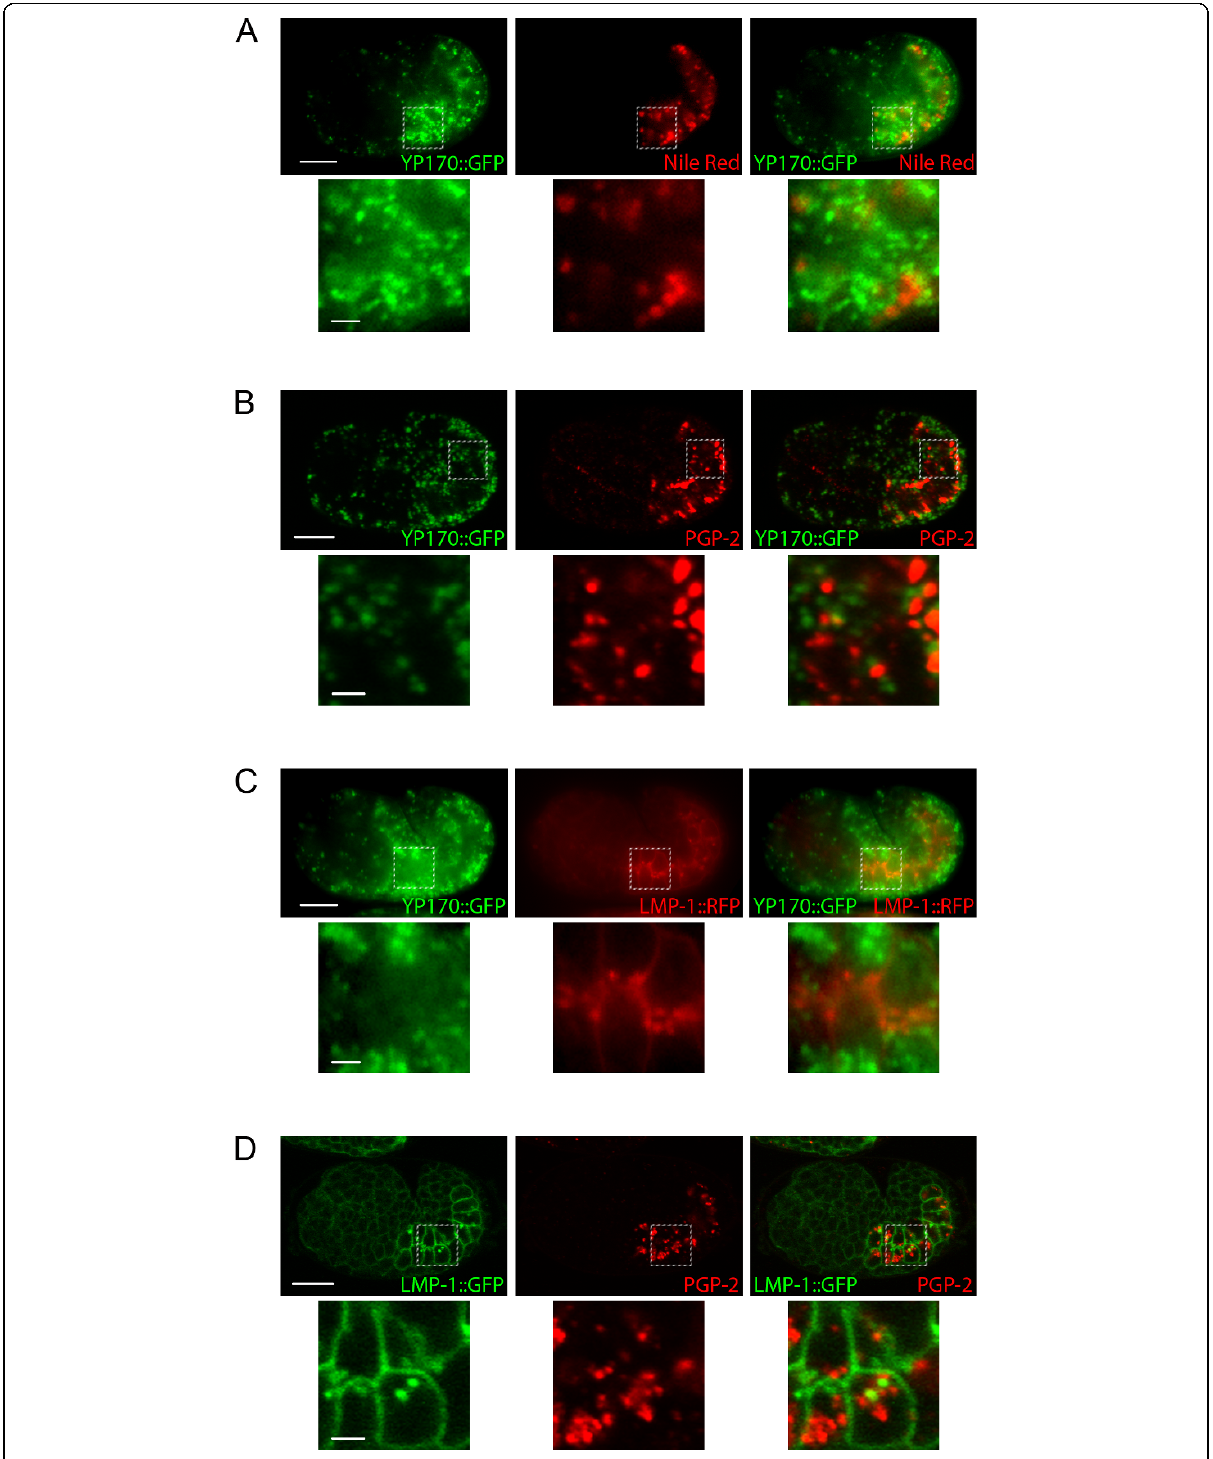
Figure 1 Late endocytic and lysosome-related organelles in developing intestinal cells of wild type embryos . A) Epifluorescence images of a wild type embryo that expresses YP170::GFP and stained with Nile Red. B) Confocal images of a wild type embryo that expresses YP170:: GFP and immunostained to detect PGP-2. C) Epifluorescence images of a wild type embryo that expresses YP170::GFP and LMP-1::TagRFP(S158T). D) Confocal images of a wild type embryo that expresses YP170::GFP and immunostained to detect PGP-2. Bottom panels are magnified images of the regions indicated in the top panels. Scale bars in whole embryo images represent 10 μ m; scale bars in magnified images represent 2 μ